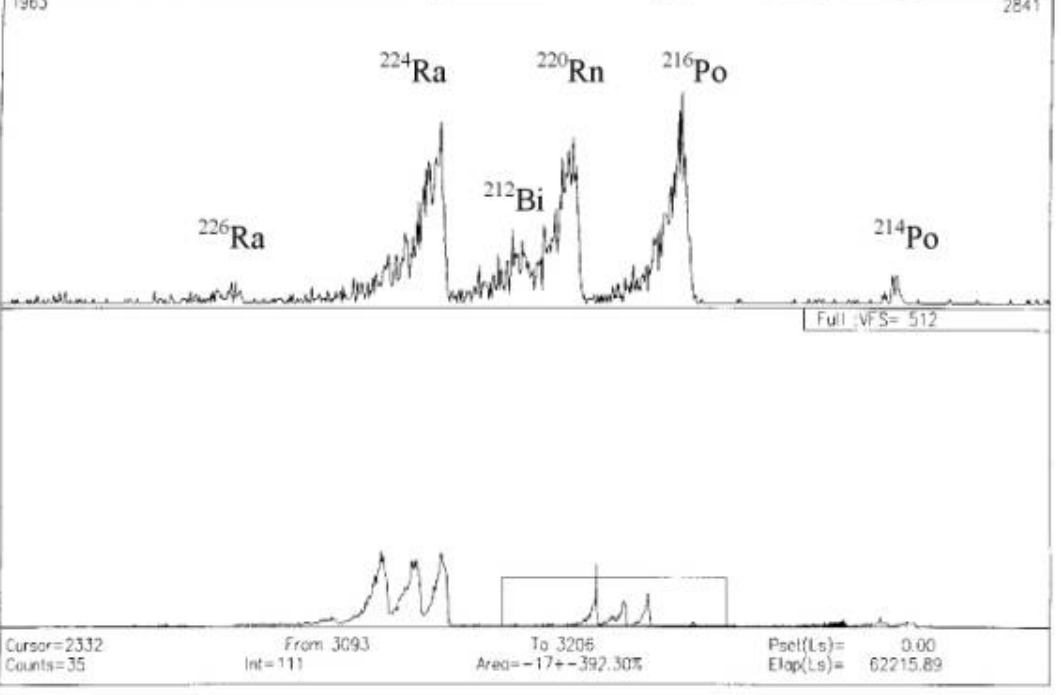
FIGURE 3A . Alpha ray spectrum for a sample IAEA RGTh-1 (thorium ore) measured right after source